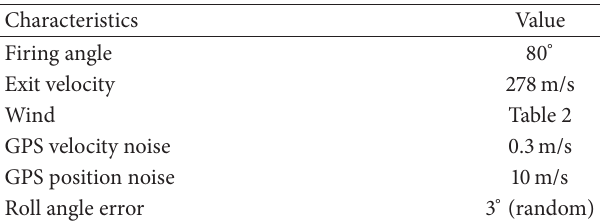
Figure 24: Experiment rig. Table 1: Simulation